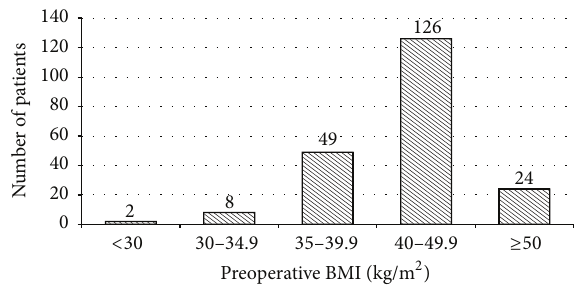
Figure 1: Distribution of patients according to preoperative BMI.